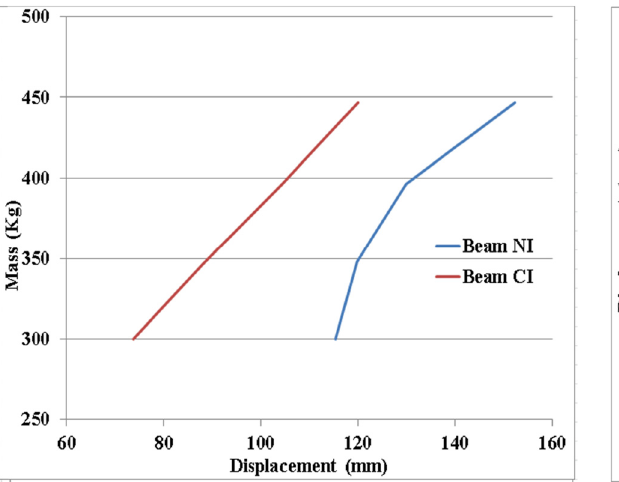
Figure 10: Displacement – time histories for various compressive strengths of